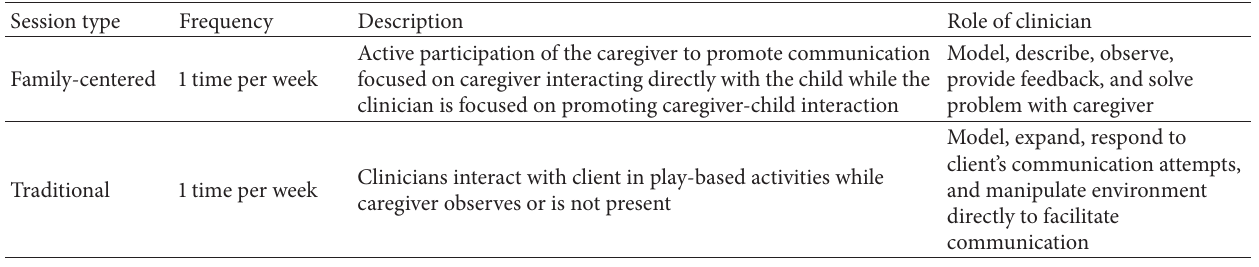
Table 1: Comparison of therapy sessions.